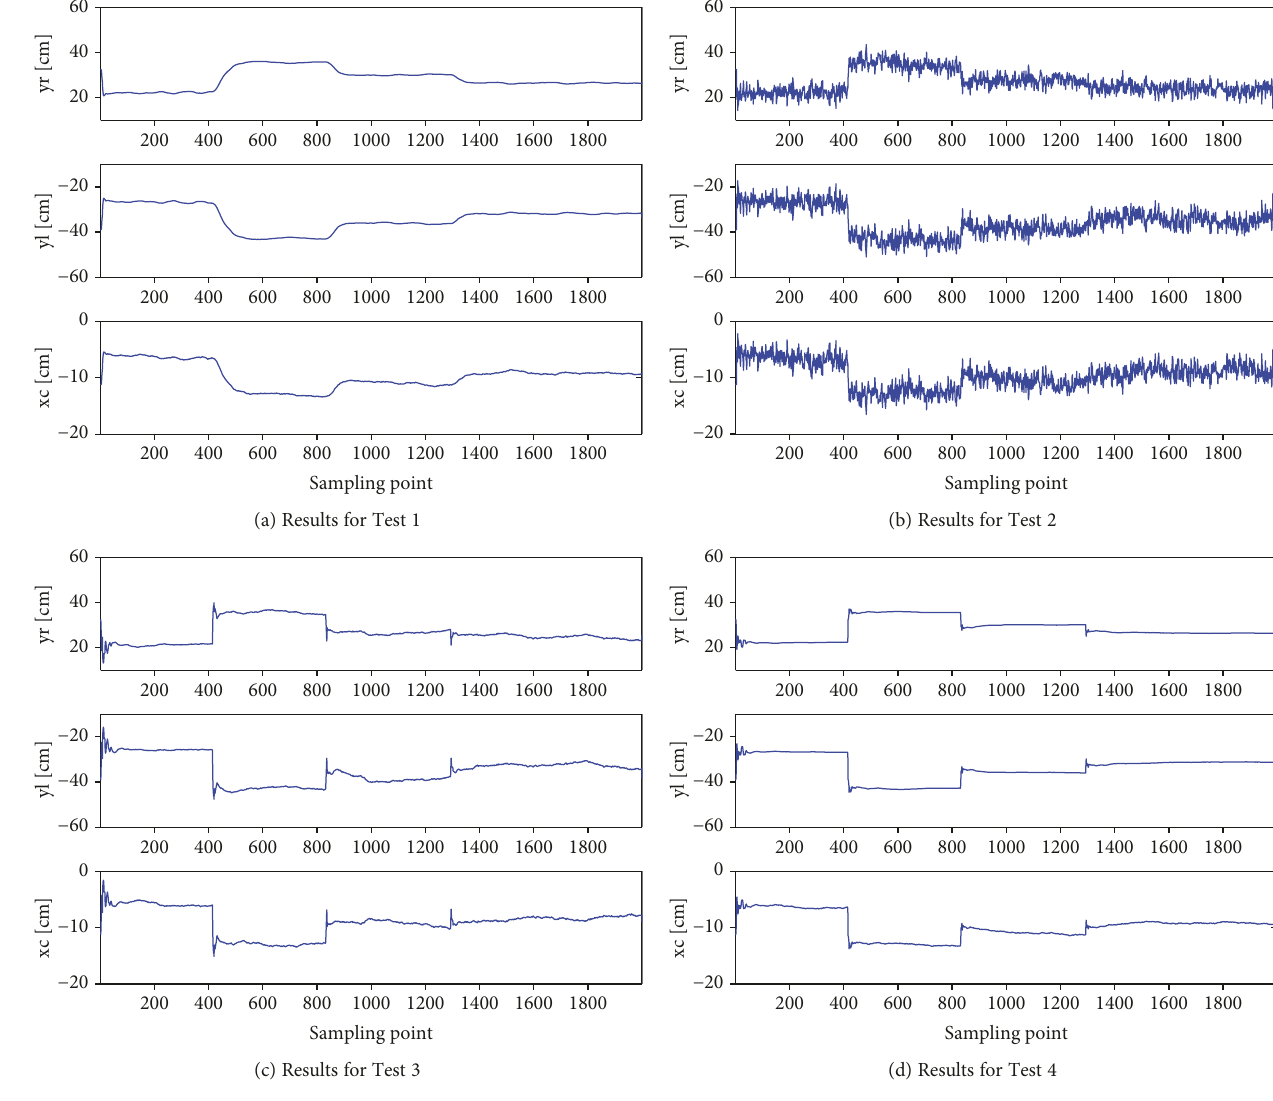
Figure 7: Results of ICR estimation